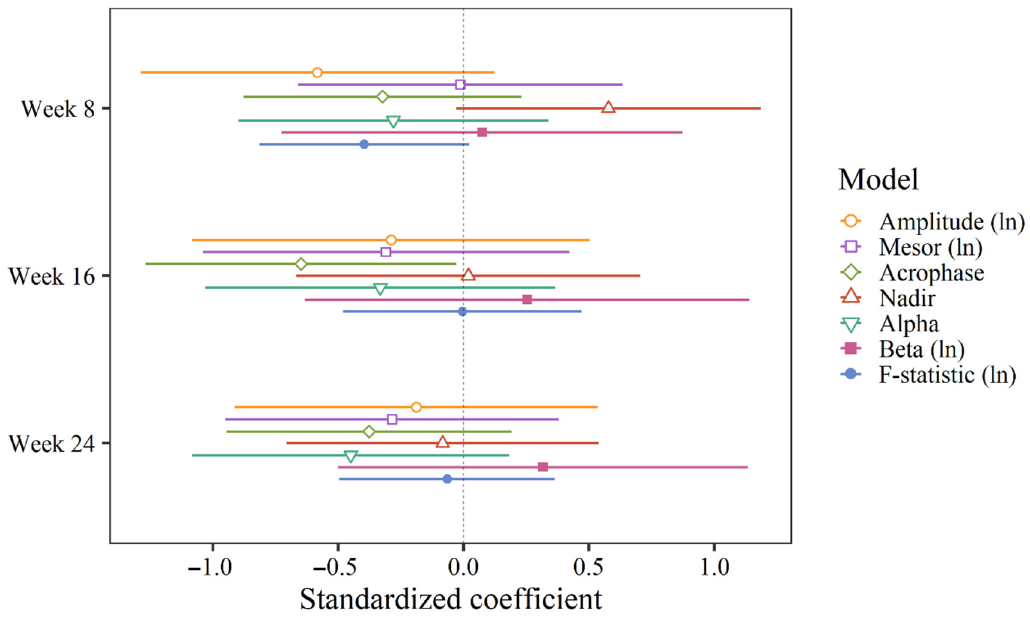
Figure 4. Standardized coefficients for week-by-condition interactions (i.e., change from baseline in the intervention group